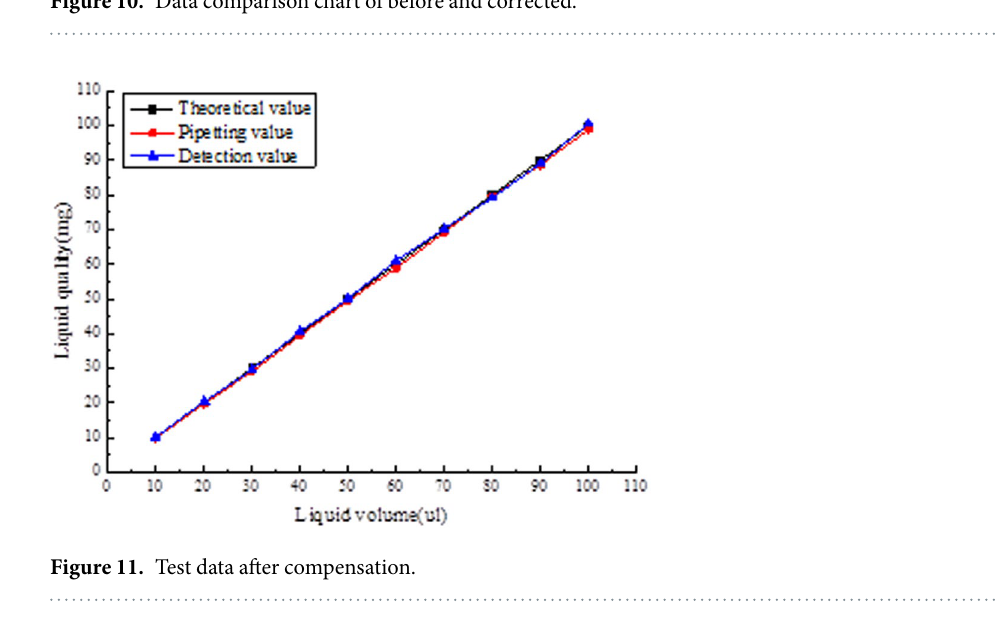
Figure 10. Data comparison chart of before and corrected.